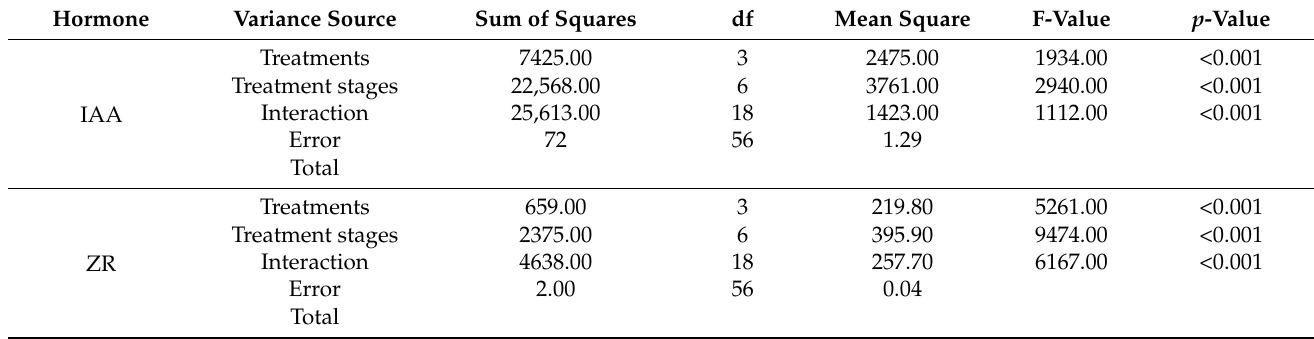
Table 1. Variance analysis of hormone concentrations in differently treated stages of